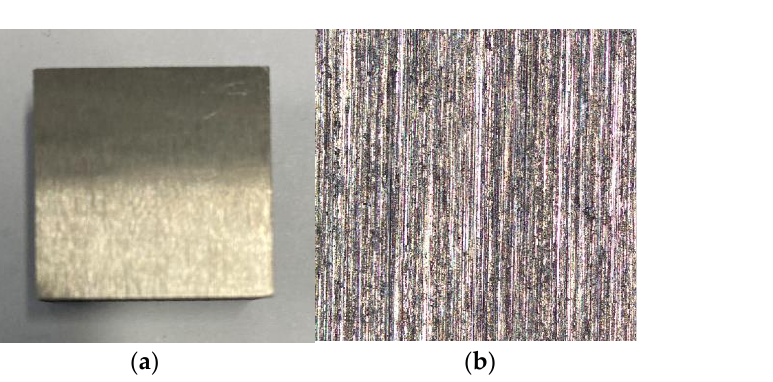
Figure 5. Surface roughness of TC4.